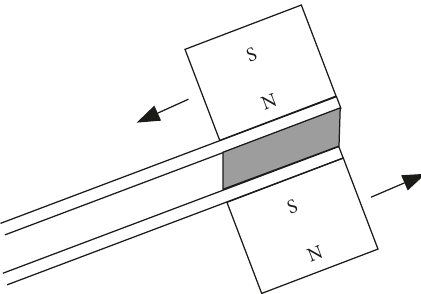
Figure 15: Alignment of magnets with the magnetic field.